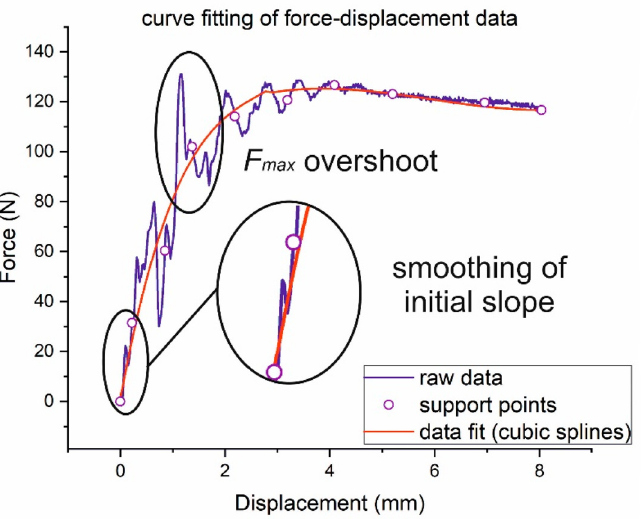
Figure A2. Curve fitting of force–displacement data from instrumented Charpy experiments. Cubic splines were fitted through 10 supporting points.